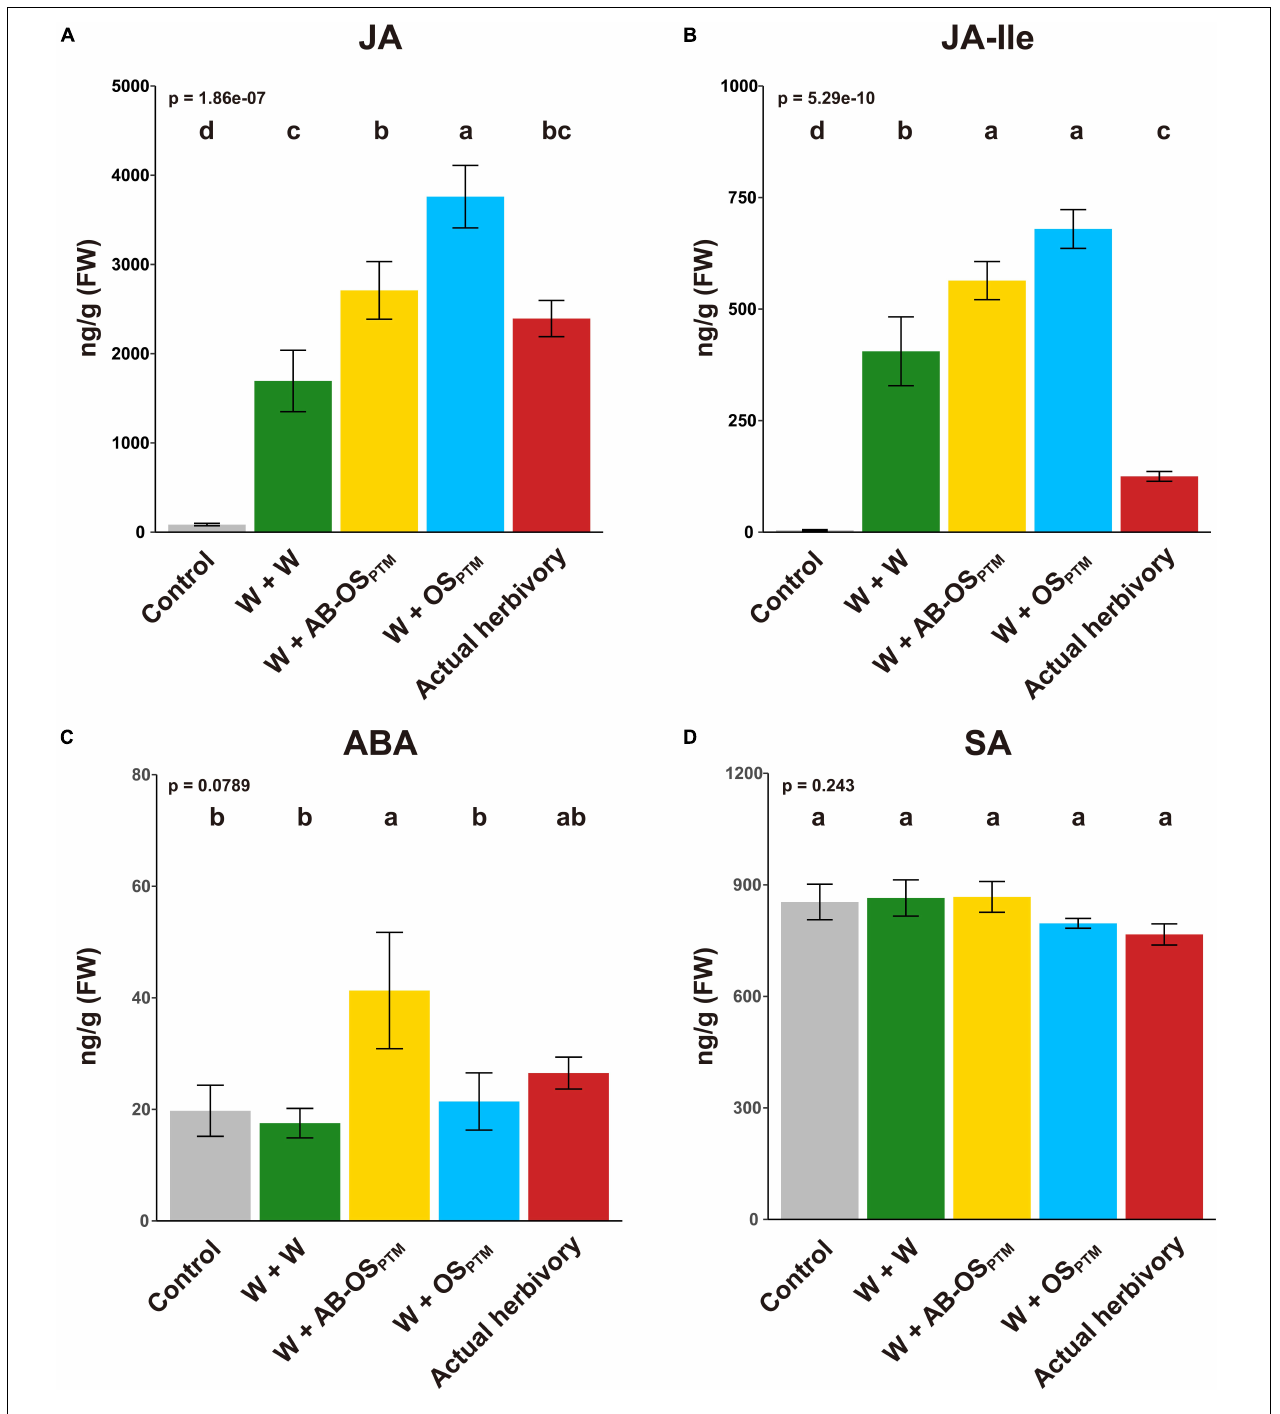
FIGURE 2 | Phytohormone levels after the induction of different herbivory stimuli. The levels of four defense phytohormones (A) JA, (B) JA-Ile, (C) ABA, and (D) SA were measured in leaves at 1 h after all treatments (mean ± SE, n = 5). The p -value of ANOVA is displayed in the upper-left corner; the result of multiple comparison (Tukey’s HSD) is shown at the top of